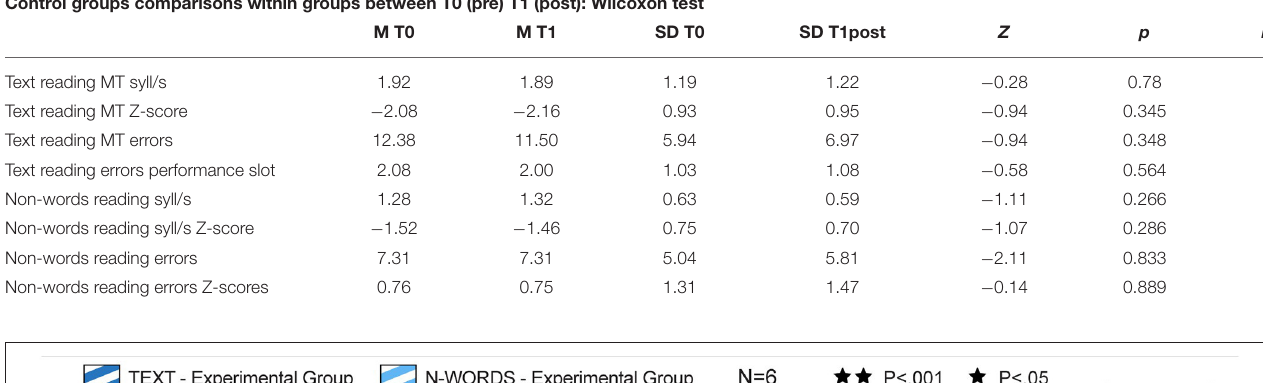
TABLE 6 | Control group, comparisons within group, calculated on Wilcoxon test for two dependents groups; number of subjects ( N ), mean pre and post training (M T0 and M T1), standard deviation (SD), Z -value of Wilcoxon ( Z ), p -value ( p ), effect size ( r ). Control groups comparisons within groups between T0 (pre) T1 (post): Wilcoxon test